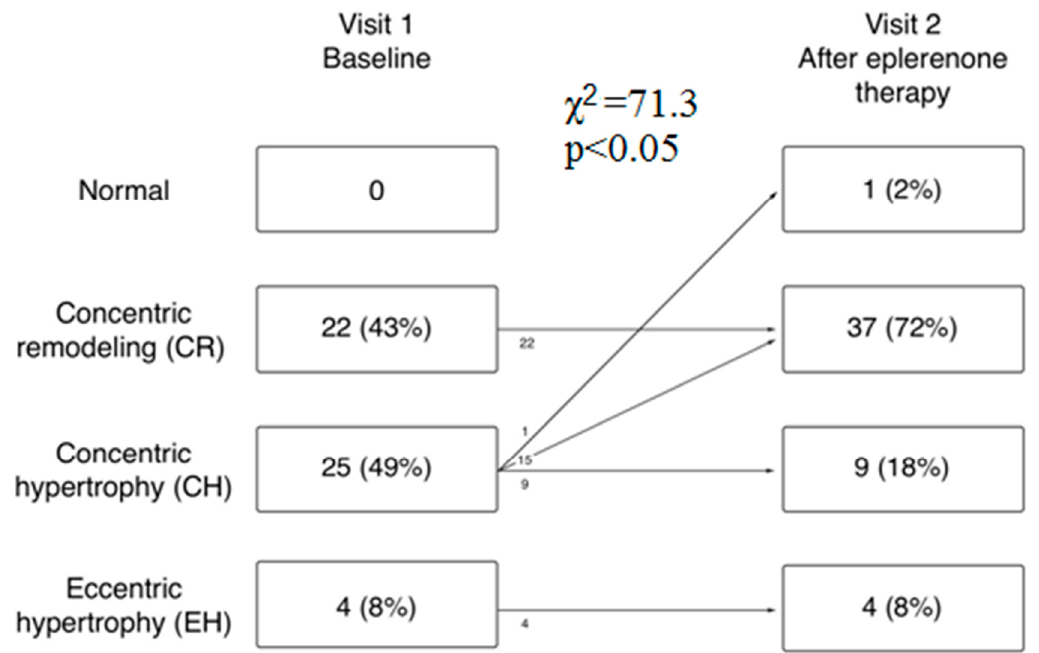
Figure 4. Left ventricular geometric patterns in patients with obstructive sleep apnea syndrome and resistant hypertension before (Visit 1) and after 6 months of eplerenone add-on therapy (Visit 2). No changes in geometric patterns were observed in the placebo group.